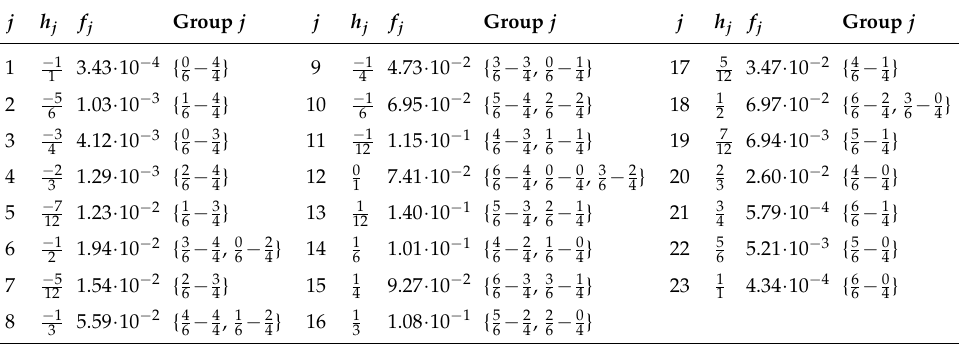
Table A4. Sorted and grouped ERs ( h j ) and their associated probabilities ( f j ) for the data in Table A1.